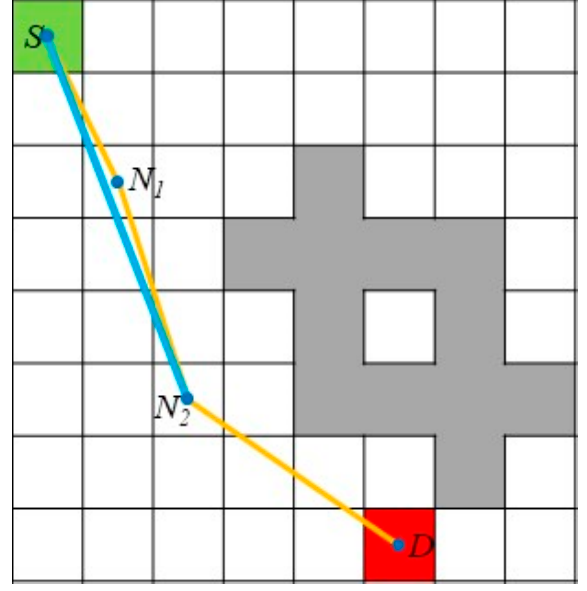
Figure 8. Schematic diagram of path smoothing.